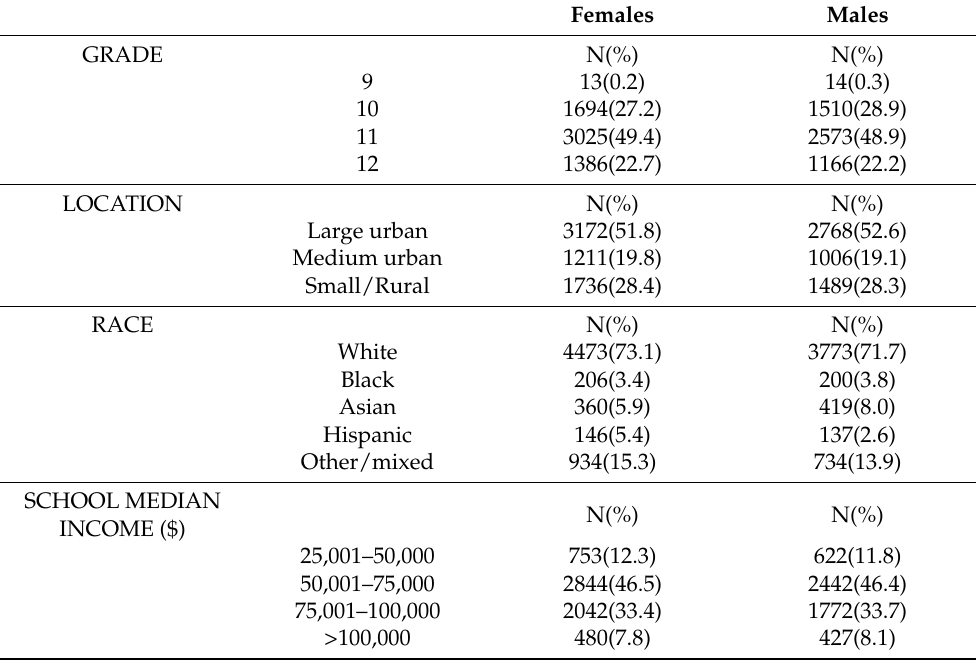
Table 1. Descriptive statistics at Time 1 (2016/2017) for the longitudinal sample of students in the COMPASS study in our analysis.